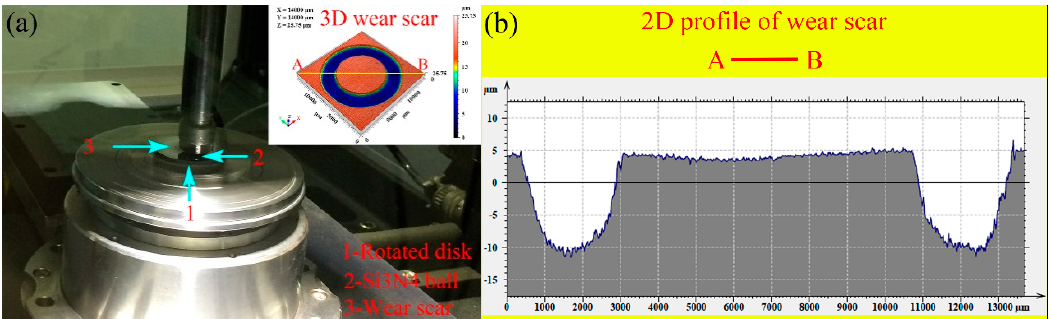
Figure 1. Wear test instrument and 3D wear scar ( a ) and 2D profile of wear scar ( b ).